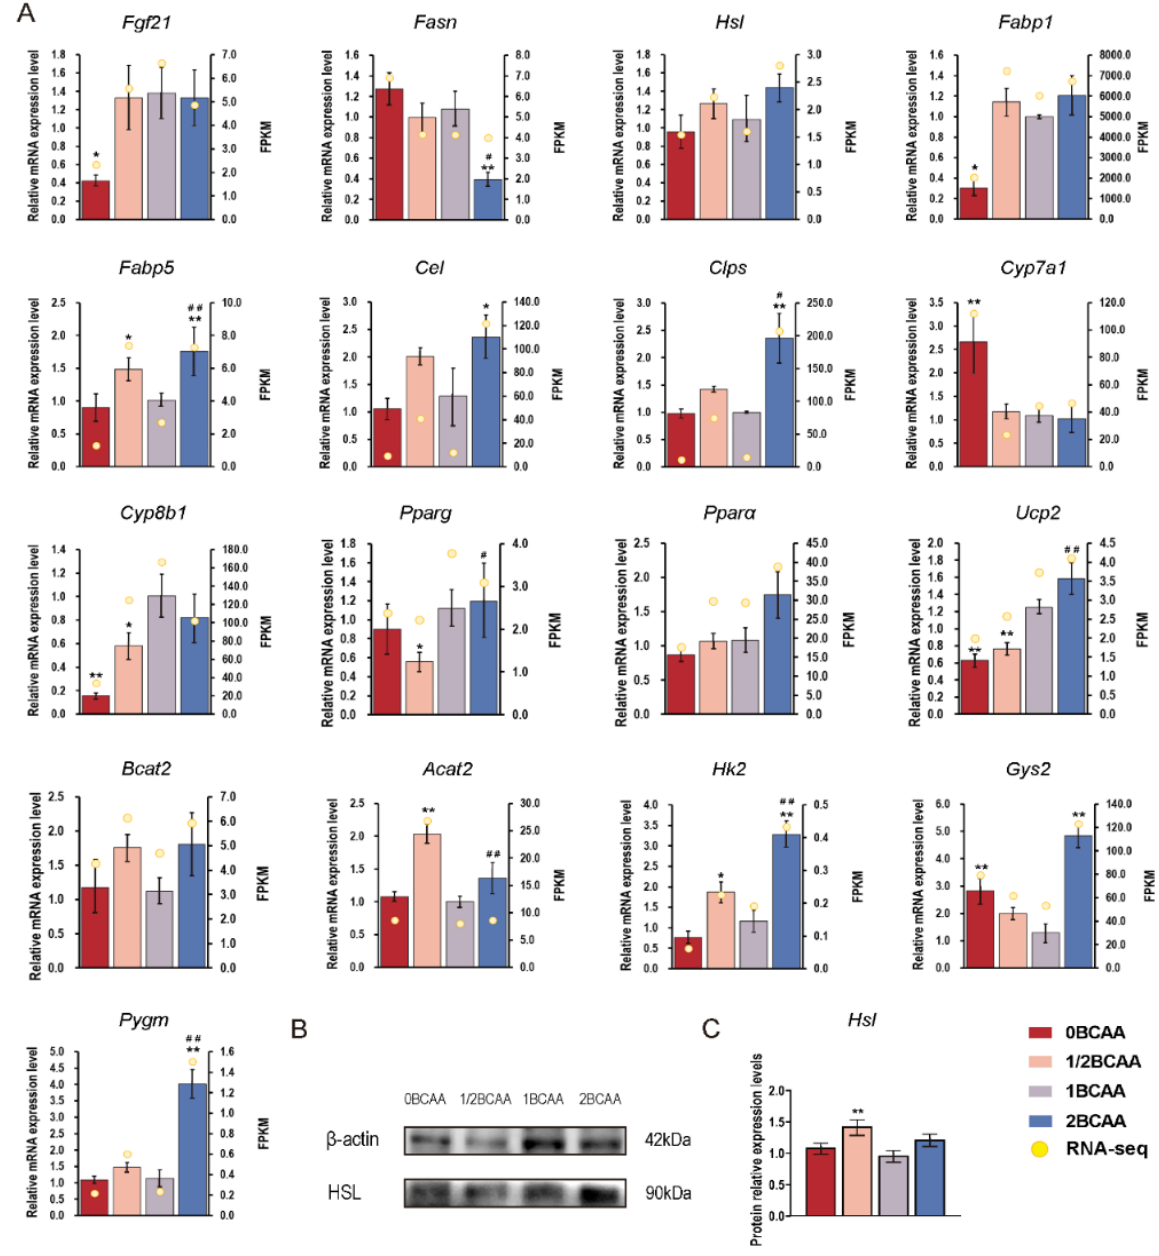
Figure 6. Effects of different dietary BCAA levels on genes related to lipid and glucose metabolism in lean mice. ( A ): RT-PCR validation of transcriptomic analysis; ( B ): Western blot analysis of HSL ; ( C ): Relative protein expression level. Values are presented as the means ± SEM (n = 8). Fgf21 : Fibroblast growth factor 21; Fasn : Fatty acid synthase; Hsl : Hormone sensitive lipase; Fabp1 : Fatty acid-binding protein 1; Fabp5 : Fatty acid-binding protein 5; Cel : Carboxyl ester lipase; Clps : Colipase; Cyp7a1 : Cytochrome P450 family 7 subfamily A member 1; Cyp8b1 : Cytochrome P450 family 8 subfamily B member 1; Pparg : Peroxisome proliferator-activated receptor gamma; Pparα : Peroxisome proliferator-activated receptor alpha; Ucp2 : Uncoupling protein 2; Bcat2 : Branched-chain aminotransferase 2; Acat2 : Acetyl-Coenzyme A acetyltransferase 2; Hk2 : Hexokinase 2; Gys2 : Glycogen synthase 2; Pygm : Muscle glycogen phosphorylase; FPKM: Fragments Per Kilobase of exon model per Million mapped fragments. * p < 0.05, ** p < 0.01 versus 1BCAA group. # p < 0.05, ## p < 0.01 in 2BCAA group versus 1/2BCAA group.